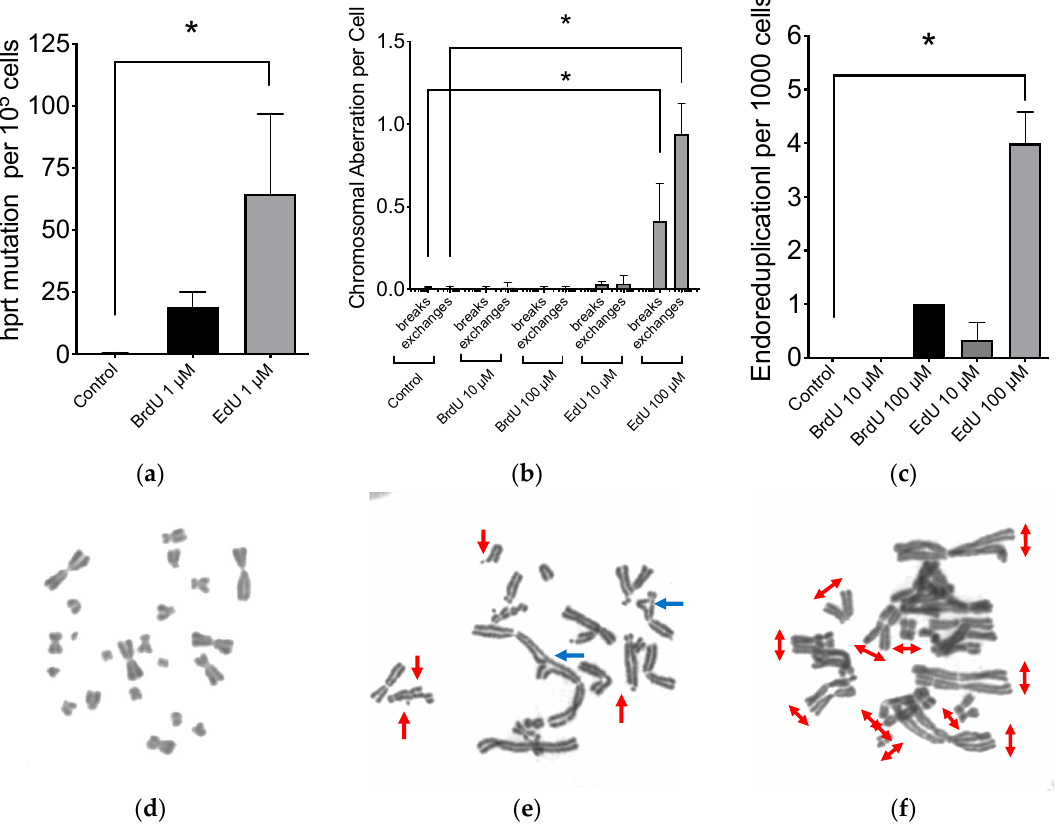
Figure 2. Genotoxicity of BrdU and EdU. ( a ) Hypoxanthine phosphorybosyl transferase (HPRT) mutation induction with BrdU and EdU; ( b ) chromosomal aberration formation in genomic instability 24 h after completing BrdU or EdU treatment; ( c ) endoreduplication formation after BrdU and EdU uptake. White bar indicates control. Black bar indicates BrdU treatment. Grey bar indicates EdU treatment. Error bars represent the standard error of the mean of three independent experiments. One-way ANOVA, Dunnett’s Multiple Comparison Test was performed to provide p -values. * indicates statistically significant di ff erences ( p < 0.05); ( d ) a representative image of CHO metaphase spread for control; ( e )arepresentativeimageofgenomicinstabilityafterEdUtreatment. Redarrowsindicatebreaks and blue arrows indicate exchanges; ( f ) a representative image of EdU-induced endoreduplication. Red arrows indicate endoreduplicated